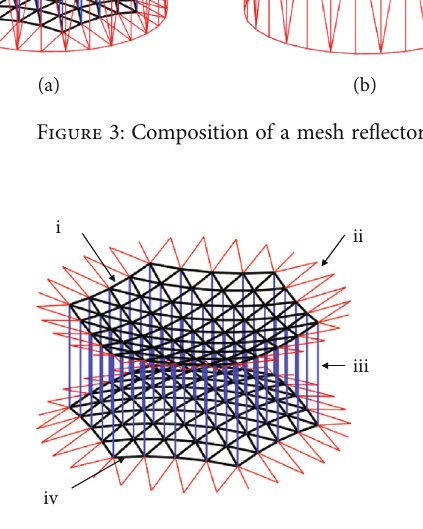
Figure 4: Schematic of a cable net structure. (a) Front cable net. (b) Boundary cables. (c) Tension tie cables. (d) Back cable net.